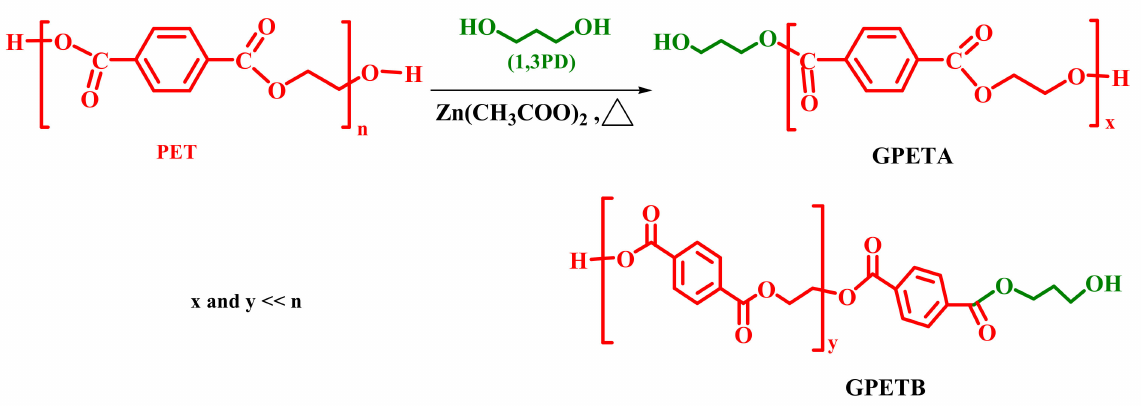
Figure 2. Reaction scheme of the PET